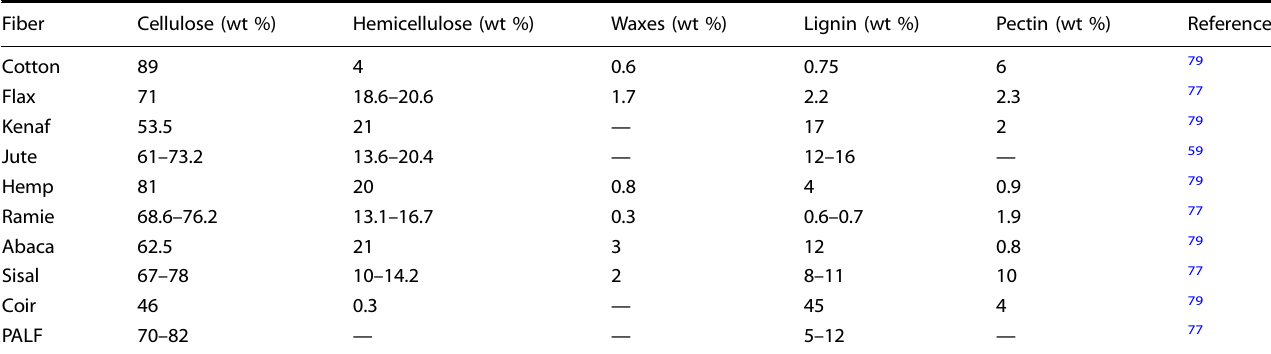
Table 1. Some natural fi bers ’ chemical composition. Fiber Cellulose (wt %) Hemicellulose (wt %) Waxes (wt